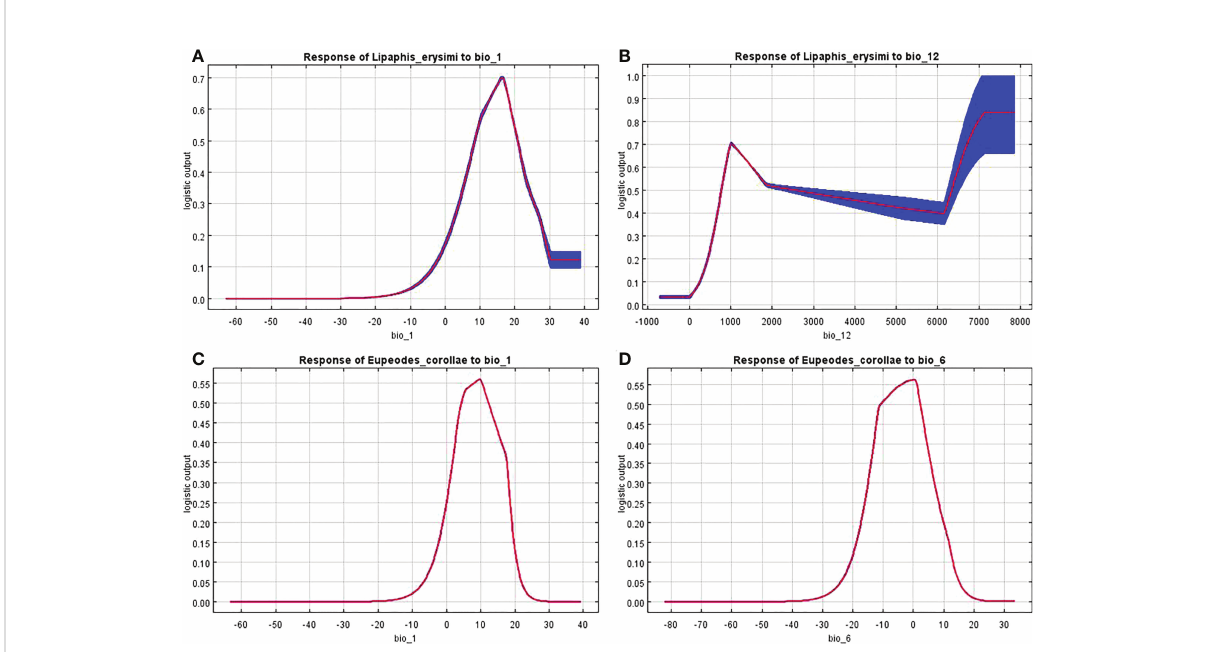
FIGURE 7 Response curve of distribution probability of L. erysimi and E . corollae to bioclimatic factors. (A) , Response curve of L. erysimi to Bio1. (B) , Response curve of L. erysimi to Bio12. (C) , Response curve of E. corollae to Bio1. (D) , Response curve of E. corollae to